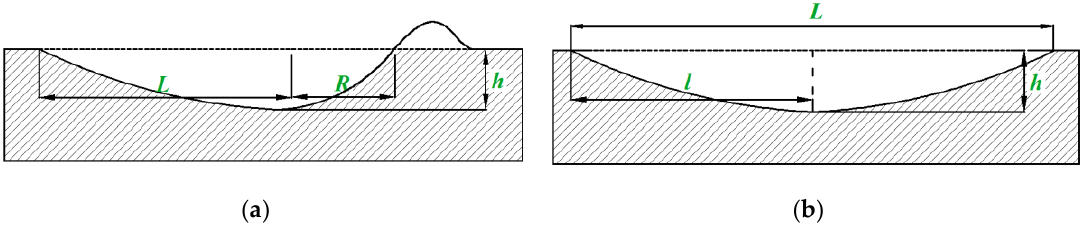
Figure 3. Schematic diagram of geometrical shape of particle impact crater: ( a ) no sliding contact; ( b ) sliding contact.